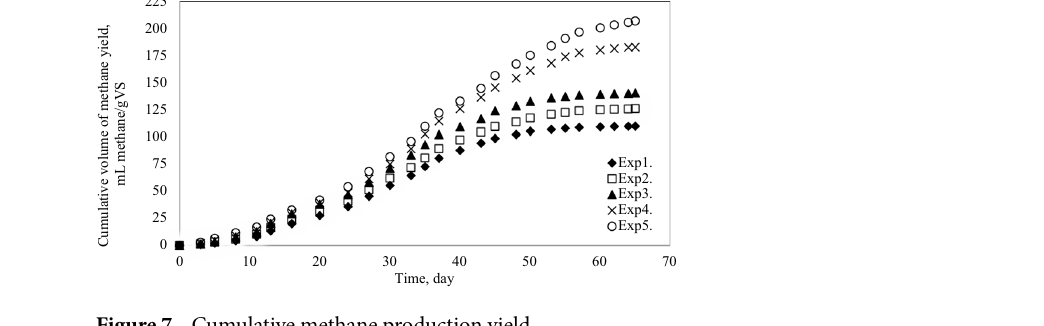
Figure 7. Cumulative methane production yield.